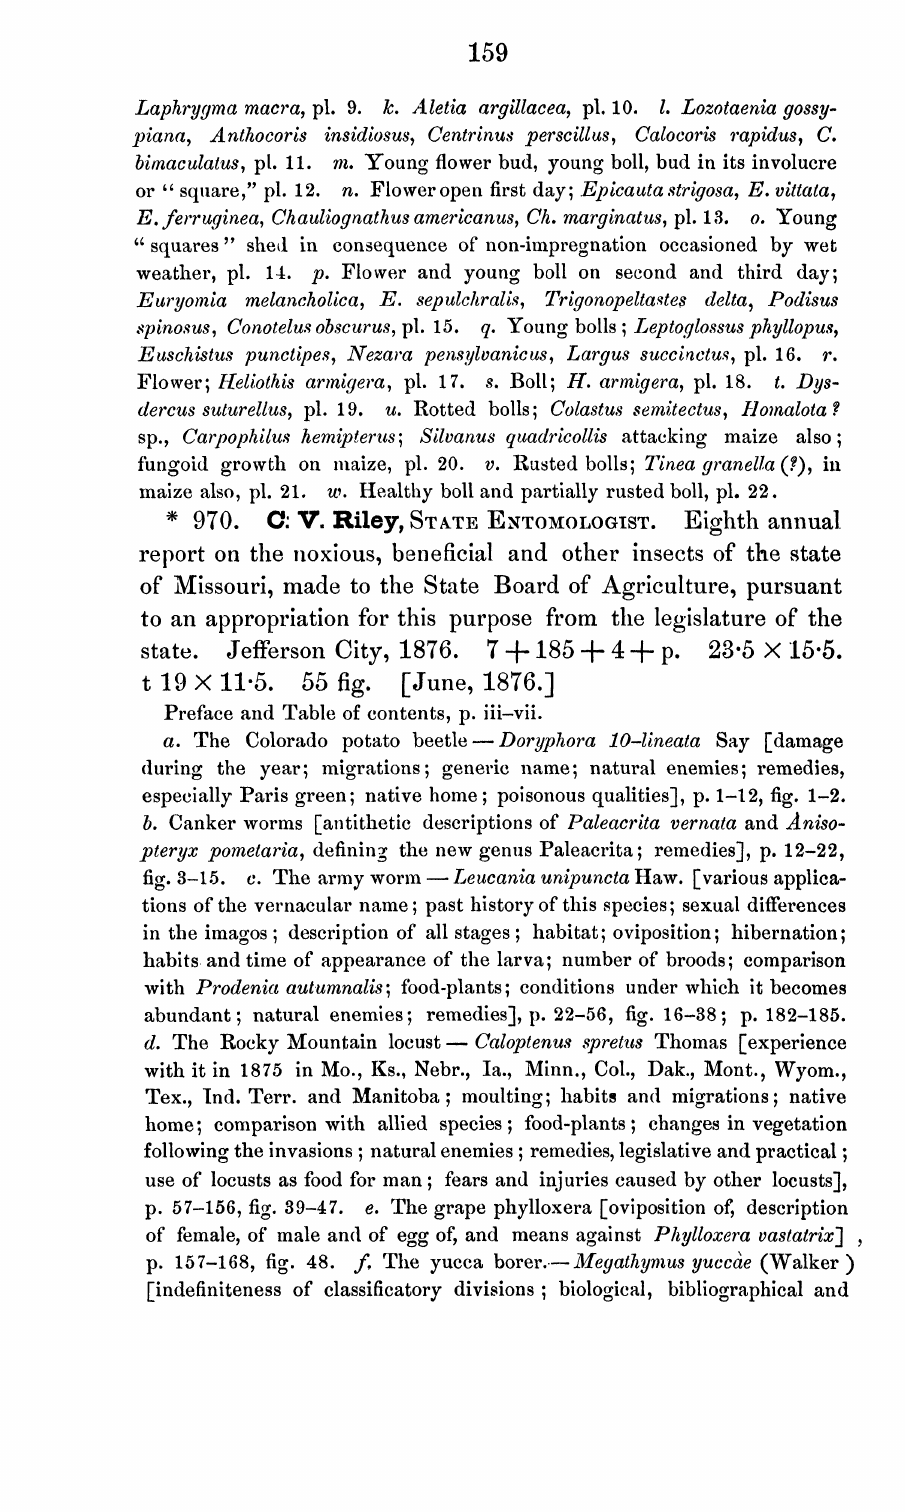
fig. 3-15. c. The army